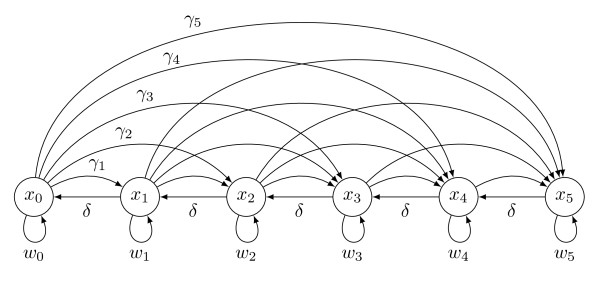
Structure of the model. Structure of the model for the case n = 5. Variables xiin the circles represent the proportion of the population carrying i genes of the 5-gene pathway in a genome. Horizontal arrows to the left indicate the effects of deletions. Curved arrows to the right show the effect of horizontal transfer. Fitnesses are depicted by arrows below populations.